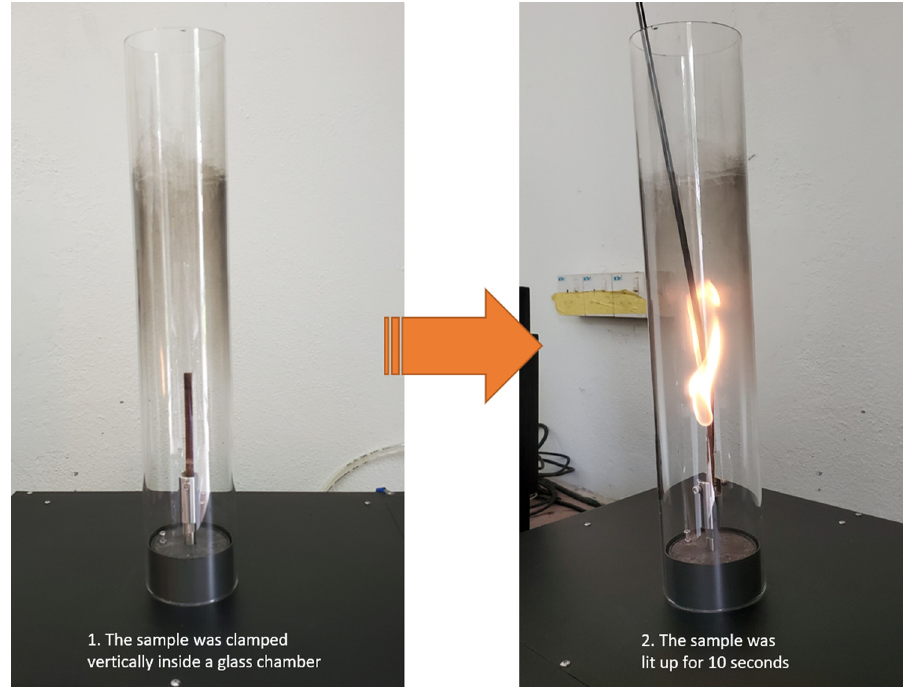
Figure 2: The experimental setup of LOI